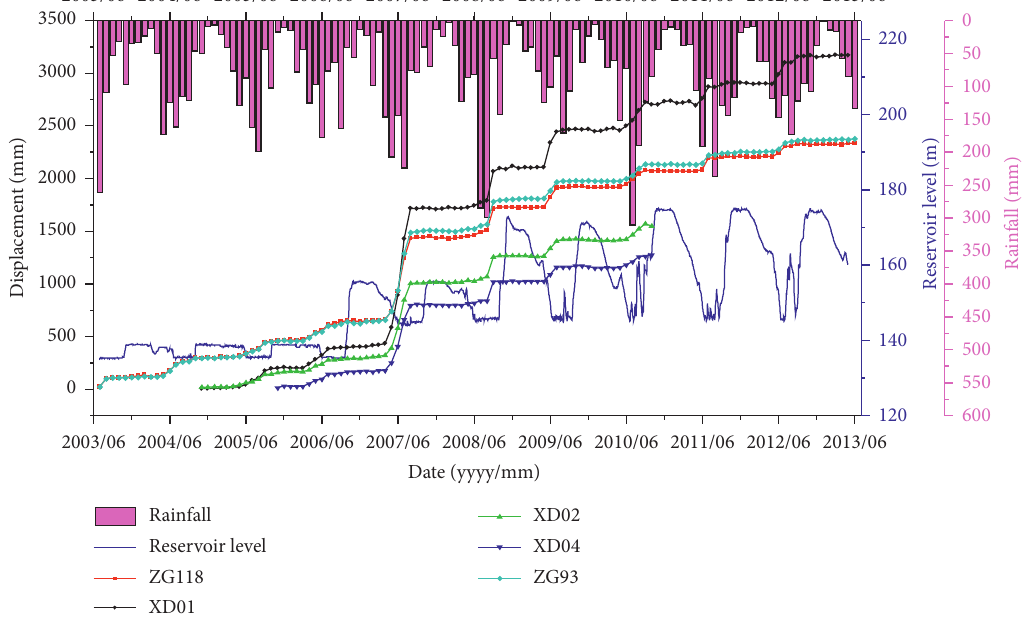
Figure 3: Monitoring data for rainfall, reservoir level, and Baishuihe landslide displacement from July 2003 to June 2013.